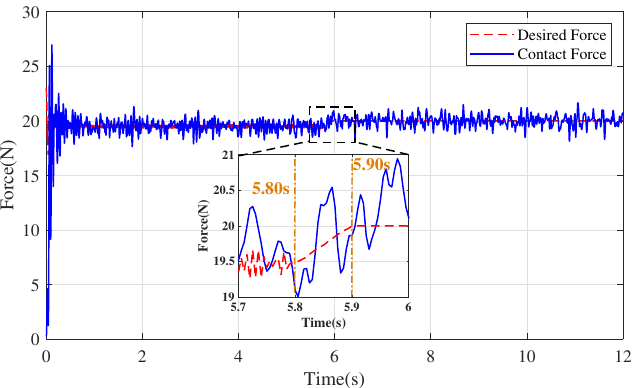
Figure 20. Impedance control without impedance matching when the polishing spindle rotates.